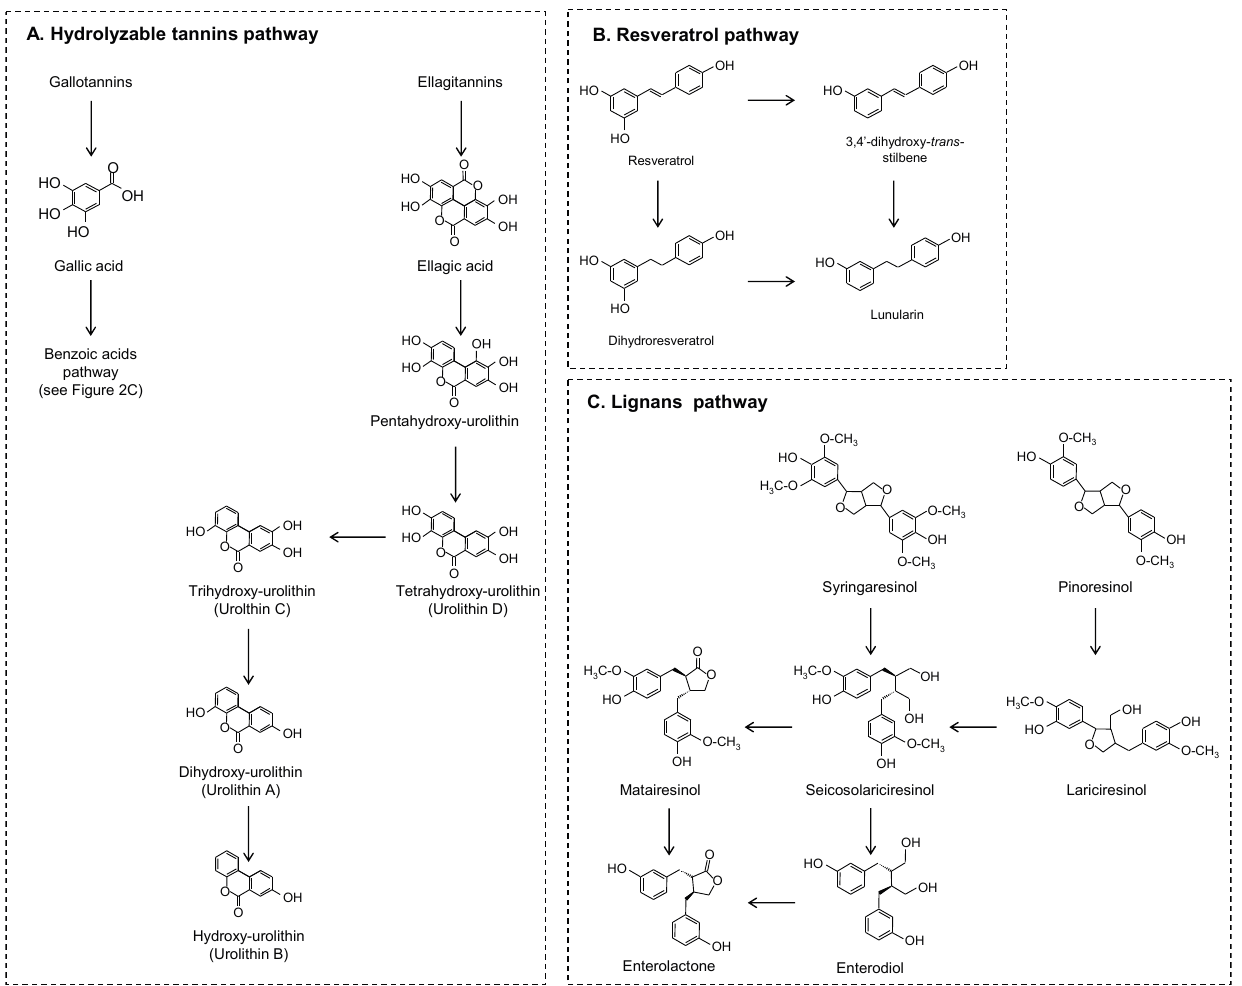
Figure 6. Proposed colonic pathways of hydrolysable tannins, resveratrol, and lignans. Resveratrol (3,5,4 ′ -trihydroxy- trans -stilbene) is the most common stilbene, present in grapes